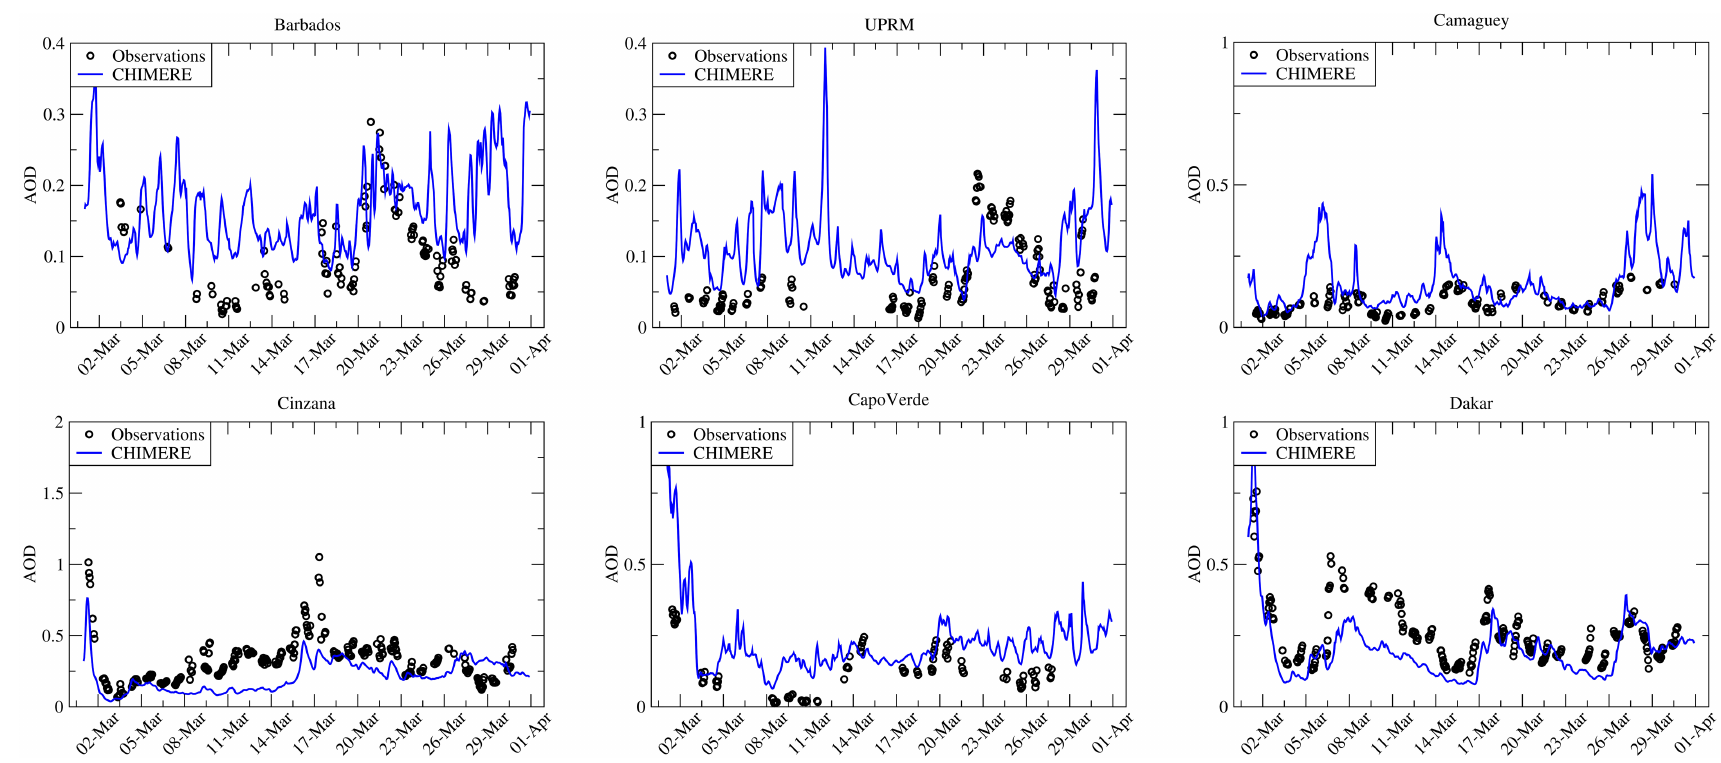
Figure 21. Time series of simulated (CHIMERE) and observed AERONET AOD 870 nm for March 2014 at Barbados (13.15 ◦ N–59.62 ◦ W), UPRM (18.21 ◦ N–67.14 ◦